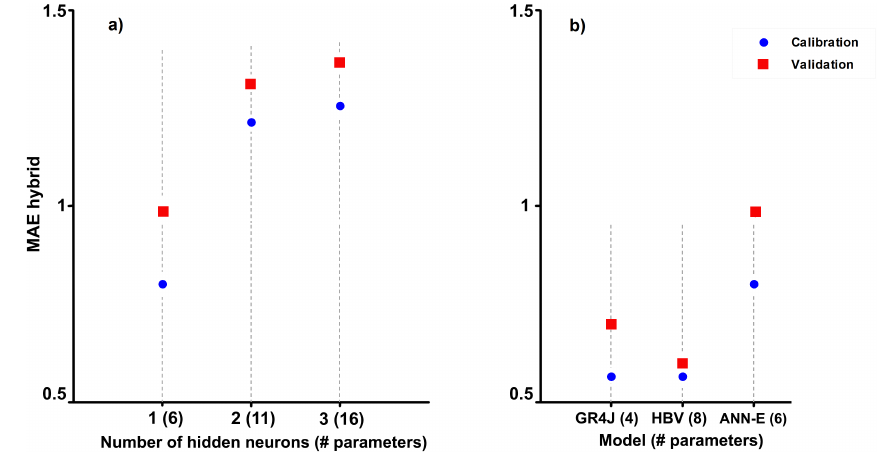
Figure 2. Calibration and validation results of (a) the ANN-E model with one, two and three hidden neurons and (b) the three models used in this study. The same calibration (1971–2001) and validation (1951–1970) periods are used for both plots.